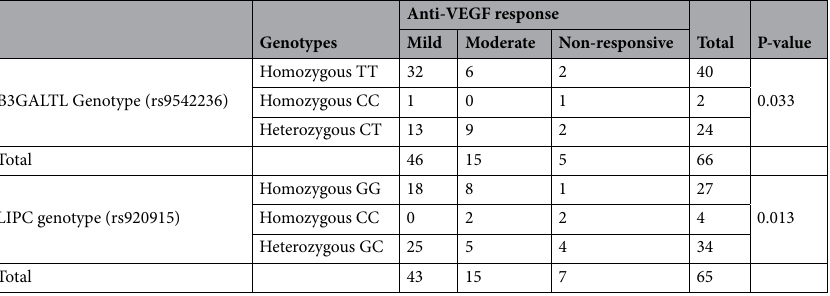
Table 2. Association of genotypes of (Pearson’s Chi -square) B3GALTL (rs9542236) and LIPC (rs920915) with number of anti-VEGF injections given to AMD patients to demonstrate the genetic susceptibility of both genes towards response of anti-VEGF treatment in AMD pathology. Mild- < 4 Avastin/year; Moderate- ≥ 5 Avastin/ year; Non-responsive- ≥ 5 Avastin/year and continuous for > 36 months.